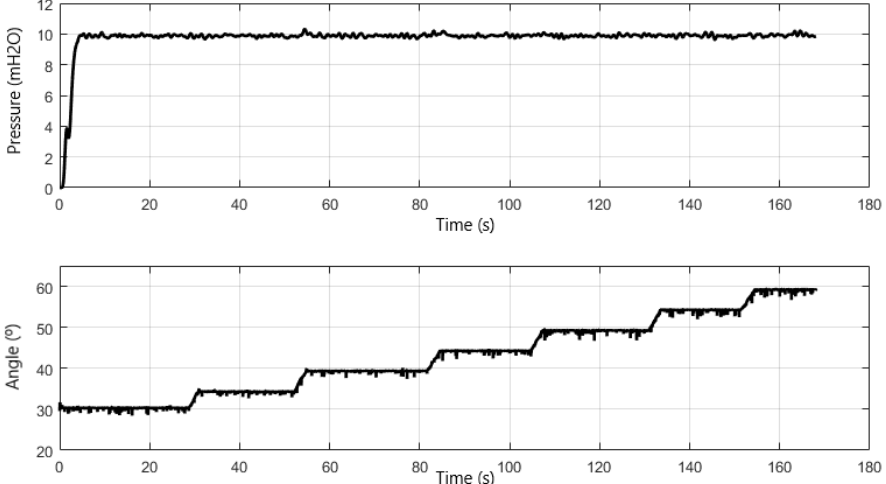
Figure 16. Response of the system operating with pumps in series to varying water